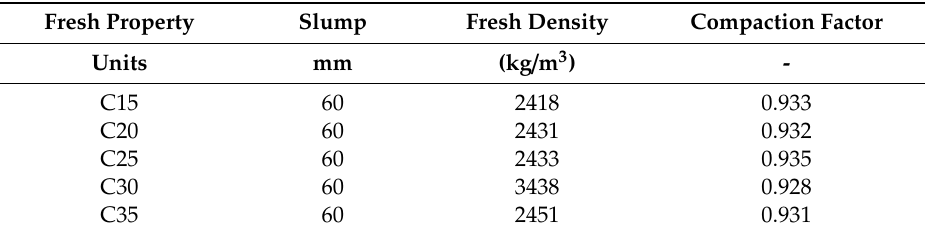
Table 3. Fresh properties of concrete